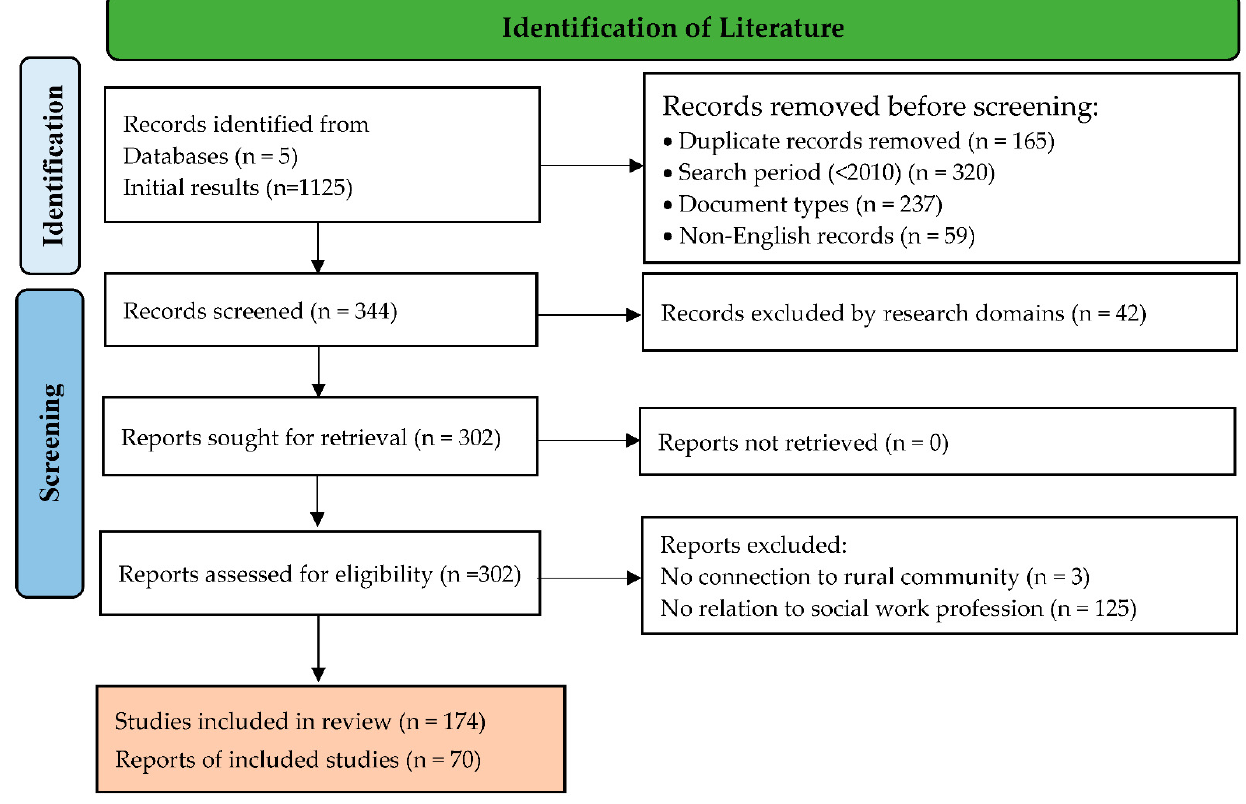
Figure 1. Screening Flowchart (Adapted from Page et al.